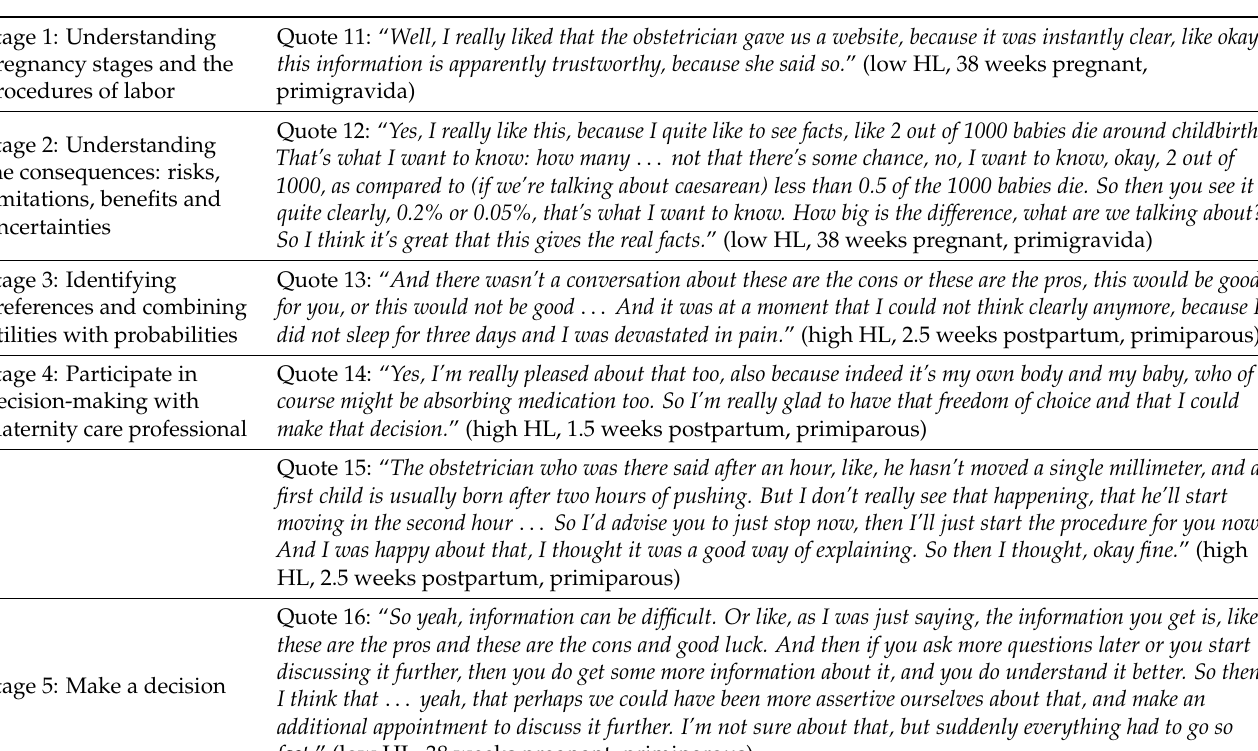
Table 4. Example quotes—perceived needs for